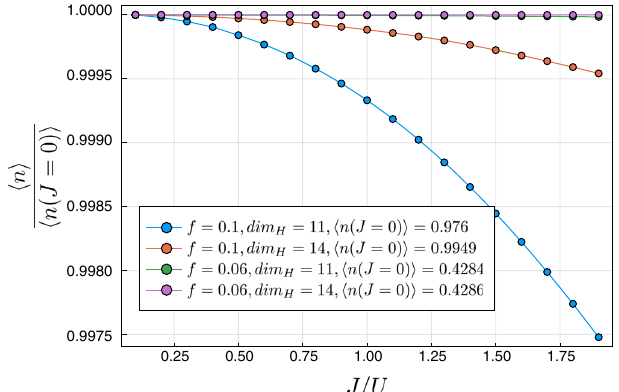
FIG. 19. Local density of particles for the BH model with single-particle losses, as a function of the hopping-to-interaction ratio J=U , for different values of the drive amplitude f , normalized to the values of the single-site problem. Parameters: z ¼ 30 , κ ¼ 0 . 2 , and dt ¼ 0 . 005